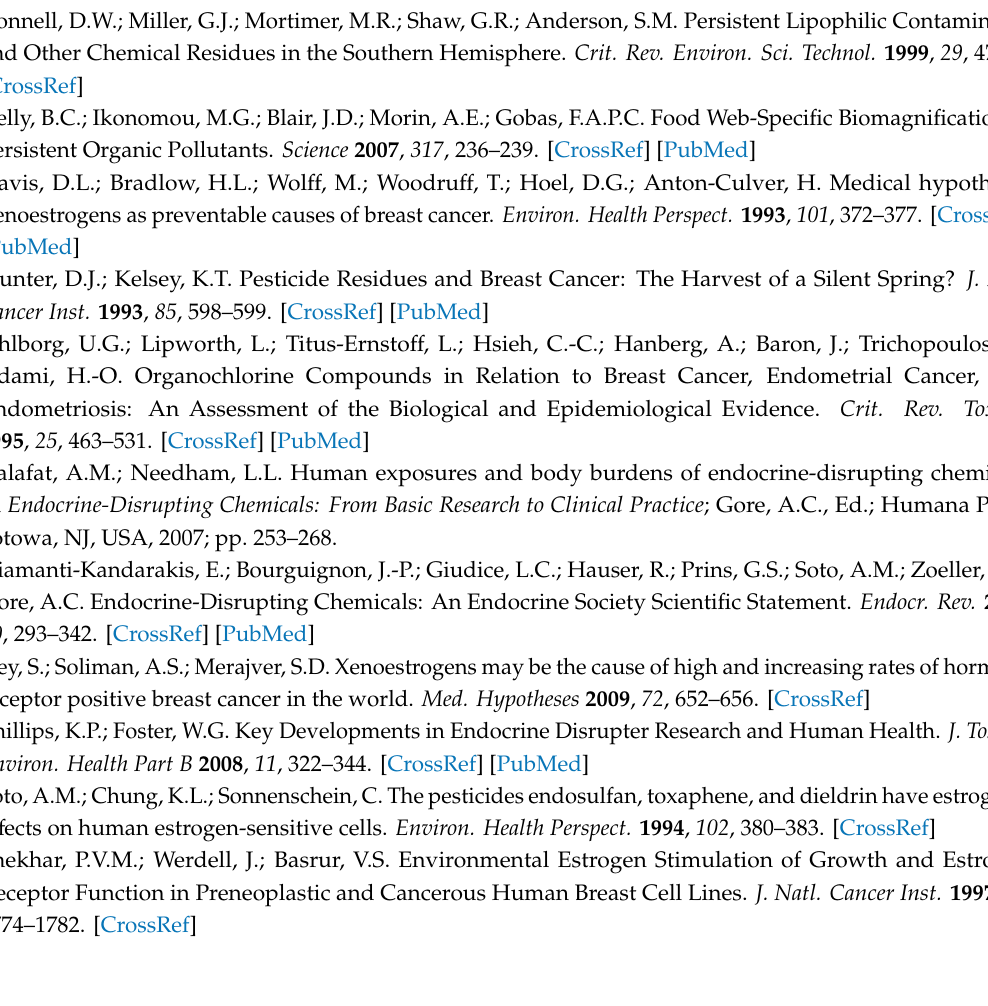
Table S1: Search strategy for Medline via PubMed, Table S2: Studies not included in the qualitative synthesis, Table S3: Studies of POPs measured in peripheral blood and breast cancer risk, Table S4: Studies of POPs measured in breast adipose tissue and breast cancer risk, Table S5: Studies of POPs measured in adipose tissue other than breast and breast cancer risk, Table S6: Studies of POPs measured in peripheral blood and mortality among breast cancer patients, Table S7: Studies of POPs measured in adipose tissue and mortality among breast cancer patients, Table S8: Studies of POPs and breast cancer prognostic factors, Table S9: Results of studies of POPs and breast cancer risk, Table S10: Results of studies of POPs and mortality in breast cancer patients, Table S11: Results of studies of POPs and prognostic factors in breast cancer patients, Table S12: Summary results of POPs associated positively with breast cancer risk, Table S13: Summary results of POPs associated negatively with breast cancer risk, Table S14: Summary results of POPs associated positively with mortality among breast cancer patient, Table S15: Summary results of POPs associated negatively with mortality among breast cancer patients, Table S16: Summary results of POPs associated positively with breast cancer prognostic